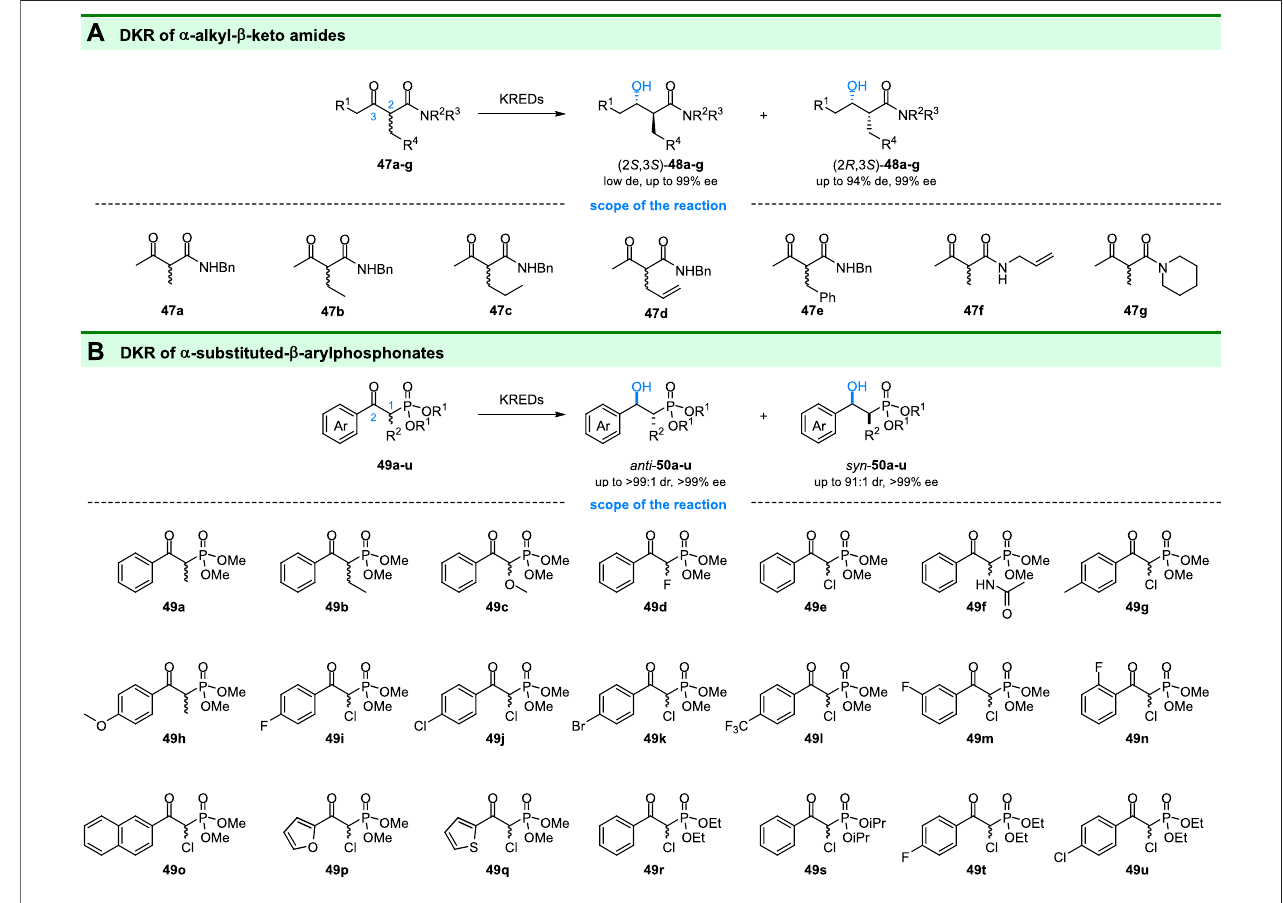
FIGURE 8 | DKR of (A) α -alkyl- β -keto amides and (B) α -substituted- β -arylphosphonates.